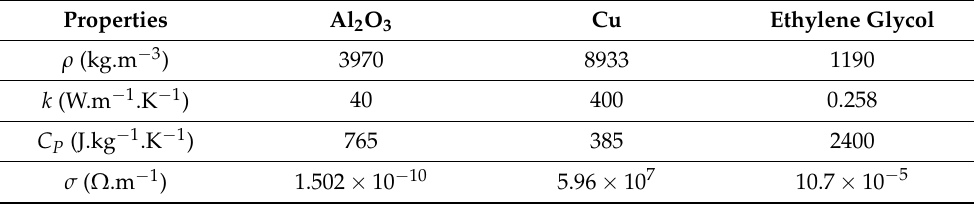
Table 1. Thermophysical properties of nanoparticles and base fluid (Sulochana et al. [17]).